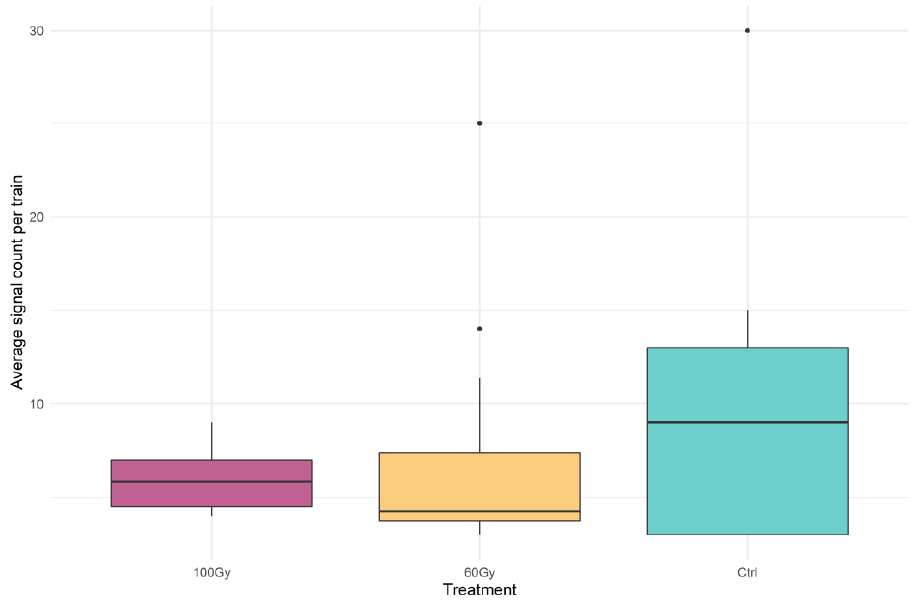
Figure 3. Box plots of the average signal count per train for each treatment. The box plots represent the interquartile range, with a horizontal bar being the median. The bottom whisker and the upper whisker represent the minimum and maximum values, respectively. The dots show the outliers.